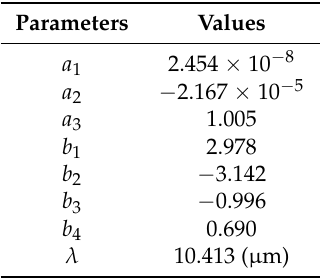
Table 1. Identified parameters of static